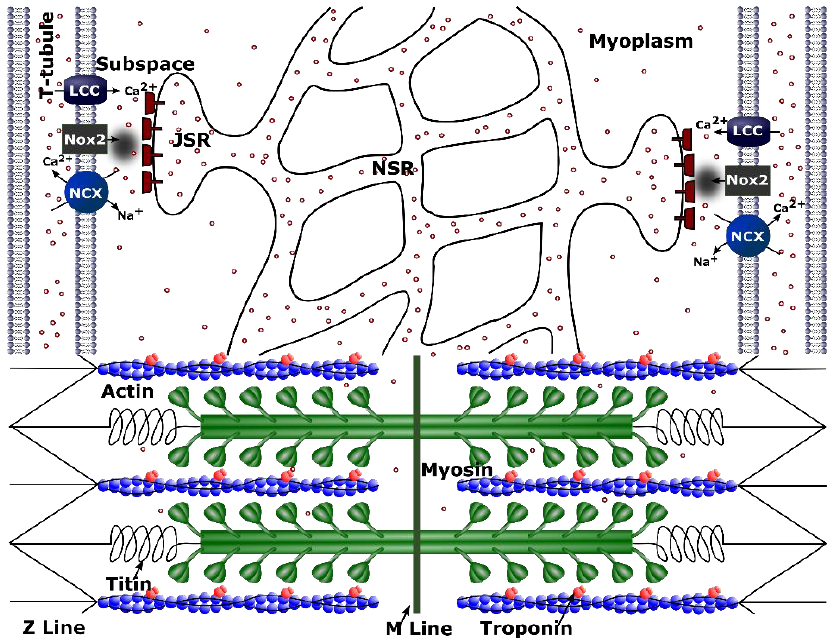
Figure 1 . Schematic figure for calcium handling model. ROS are produced by NOX2 close to the Ca 2+ release site as a result of stretching. Only one of the 20,000 Ca 2+ release units from the model of a single cell is shown. Purple circles indicate calcium ions (Ca 2+ ). Other abbreviations: NCX — Na + -Ca 2+ exchanger; PMCA — plasmalemmal Ca 2+ -ATPase; I Na — sodium current; I to — transient outward potassium current; I K1 — potassium current; LCC — L-type Ca 2+ current; RYR2 — ryanodine receptor channel; ROS — reactive oxygen species; NOX2 — NADPH oxidase type 2; CSQ — calsequestrin; JSR — junctional sarcoplasmic reticulum; NSR — network sarcoplasmic reticulum; CaM —